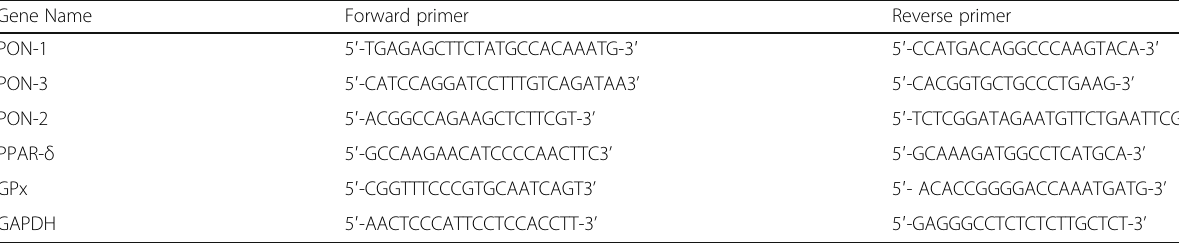
Table 1 The primers sequences that used in this study